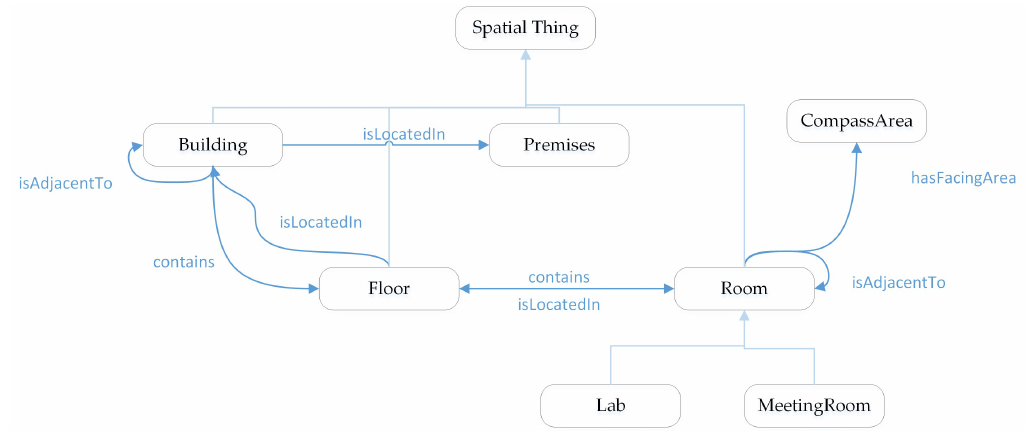
Figure 5. An ontology example for indoor location